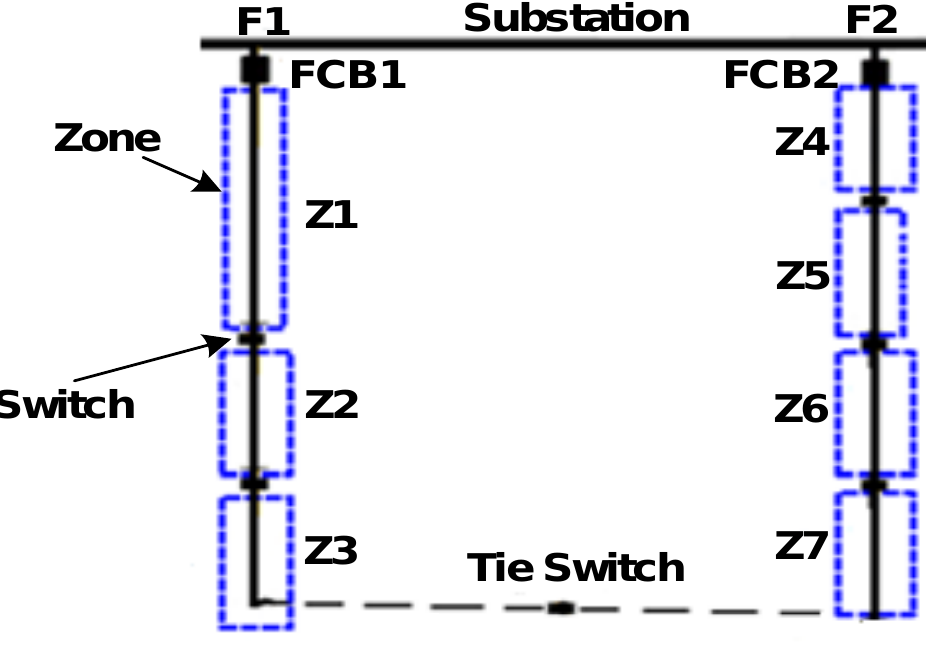
Figure 1. Zone concept in distribution systems.